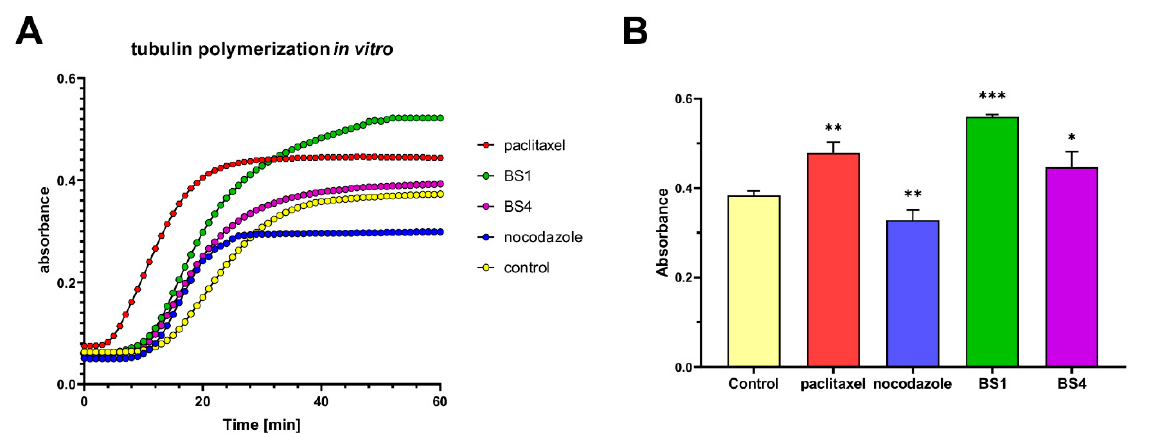
Figure 4. Impact of the tested sulfonic styrylquinazoline ( BS1 and BS4 ), paclitaxel and nocodazole at a concentration of 10 µ M on tubulin polymerization in vitro ( A ). Data chart with maximum value absorbance of each compound with the statistical analysis using a one-way ANOVA with Bonferroni’s post-hoc test: * p < 0.05, ** p < 0.01, *** p < 0.001 compared to the control ( B ).